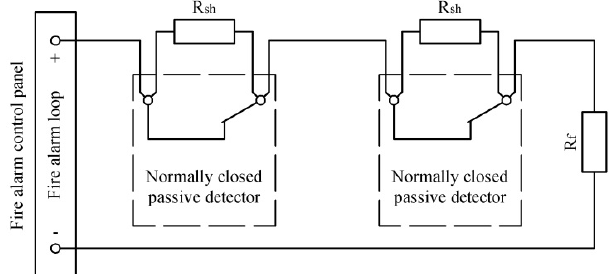
Figure 5. Circuit for connecting normally-locked FA with a shunt resistor to a two-wire loop R sh – shunt resistor; R f – final resistor